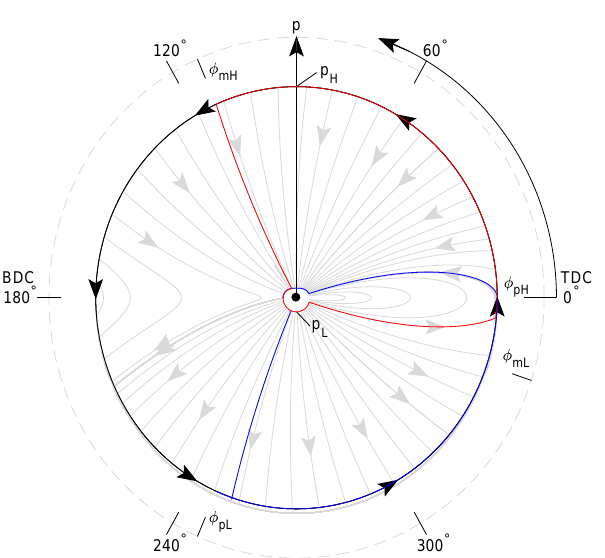
Figure 6: Phase portrait of the pressure dynamics as function of the angle. Red trajectory illus- trates a 70% partial motoring stroke and blue trajectory illustrates a 70 % partial pumping stroke.